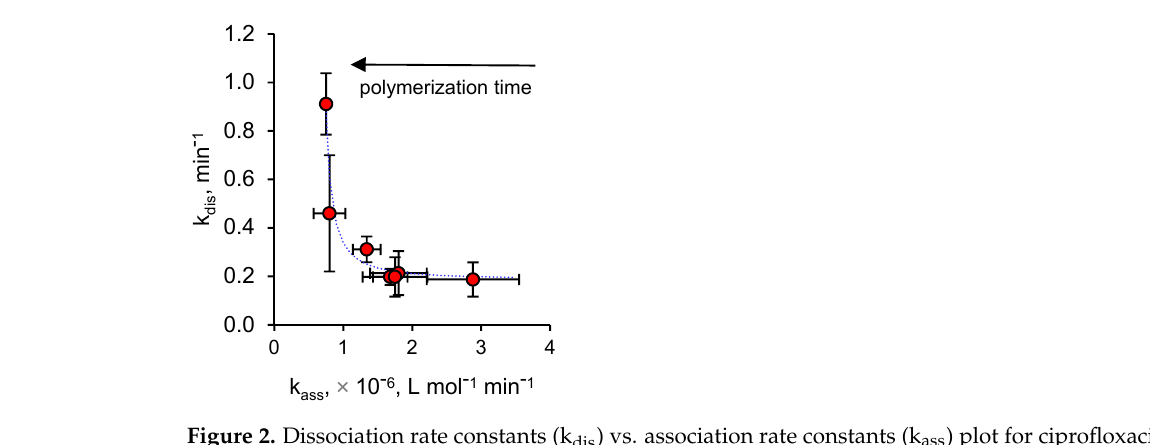
Figure 2. Dissociation rate constants (k dis ) vs. association rate constants (k ass ) plot for ciprofloxacin on ciprofloxacin-nanoMIPs. Error bars indicate 1 standard error unit.